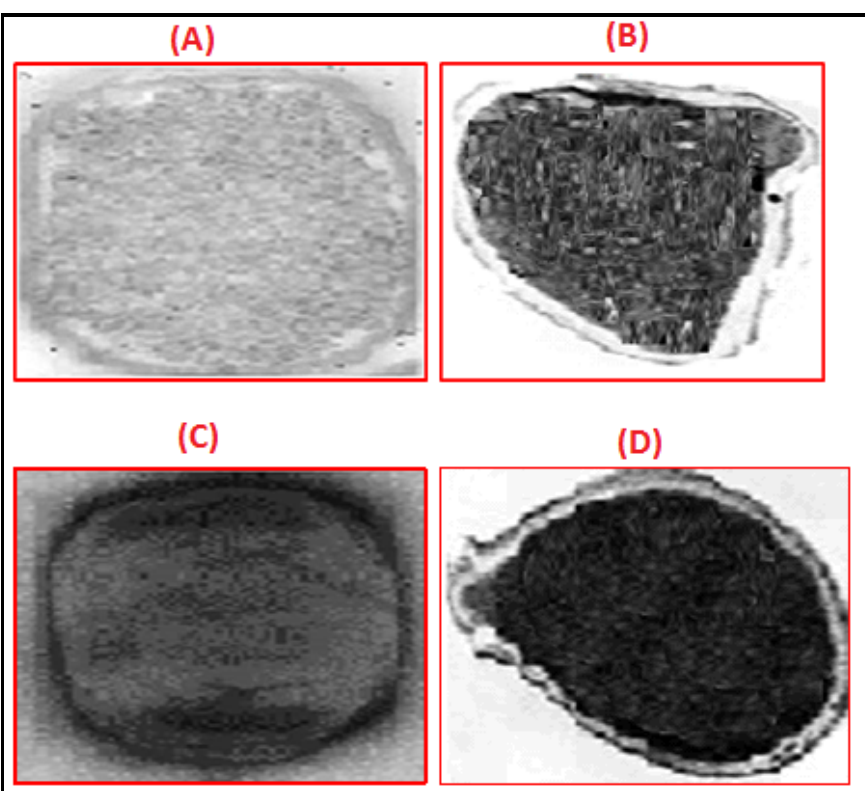
Figure 2. Transmission electron micrographs of untreated and thymol nanoemulsion treated S. Enteritidis. ( A , C ) are untreated multidrug resistant (MDR) and extensively drug resistant (XDR) strains with complete cell walls and cell structures. Meanwhile, ( B , D ) are MDR and XDR strains with damaged cell membranes and cell walls with complete cell destruction after exposure to MBC doses of thymol nanoemulsion.